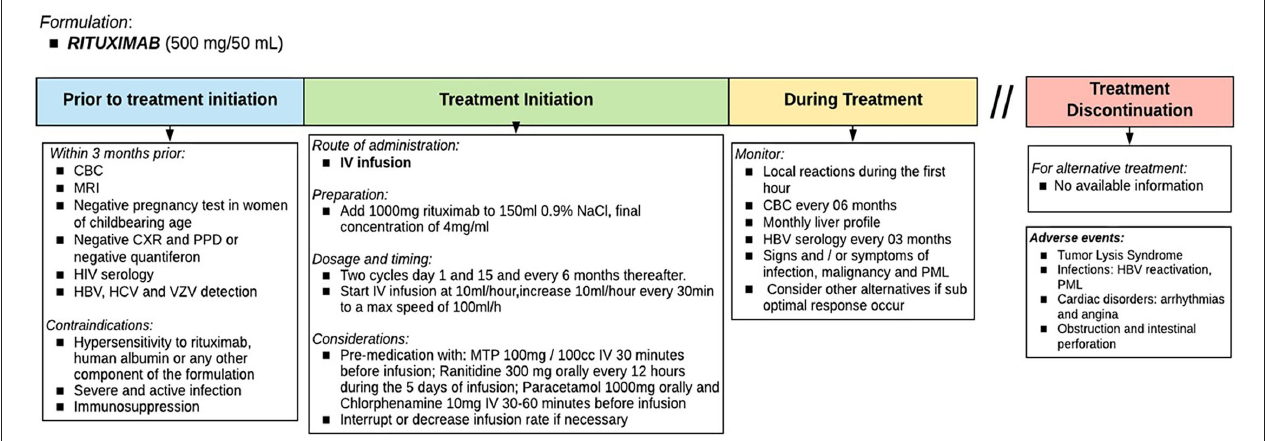
FIGURE 6 | Therapeutic protocol for failure: Rituximab. The indication of rituximab as a DMT in RRMS has not yet been approved in Peru and is used as an off-label indication. Source: Authors.